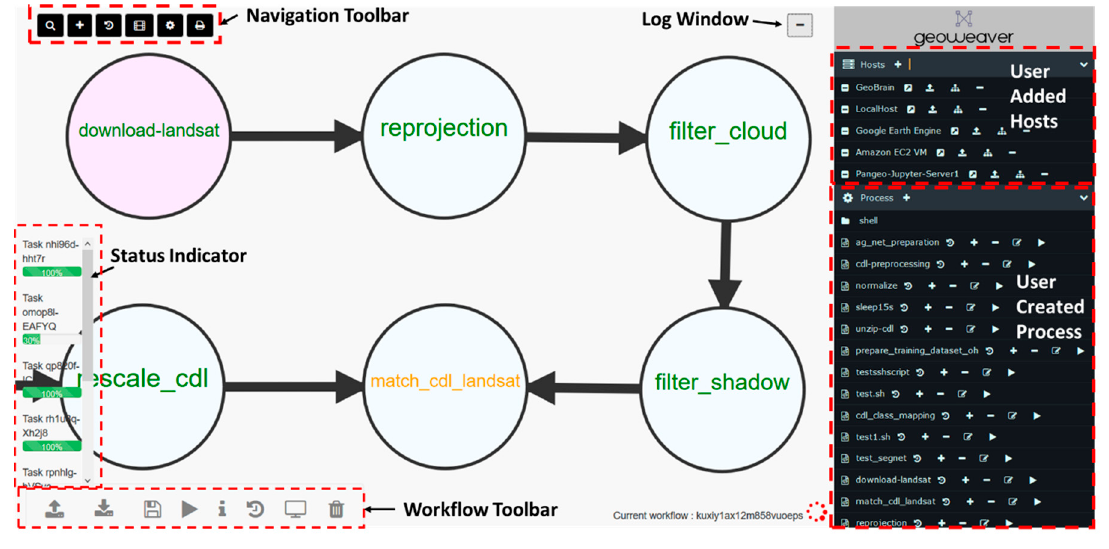
Figure 3. Geoweaver. Figure 3.